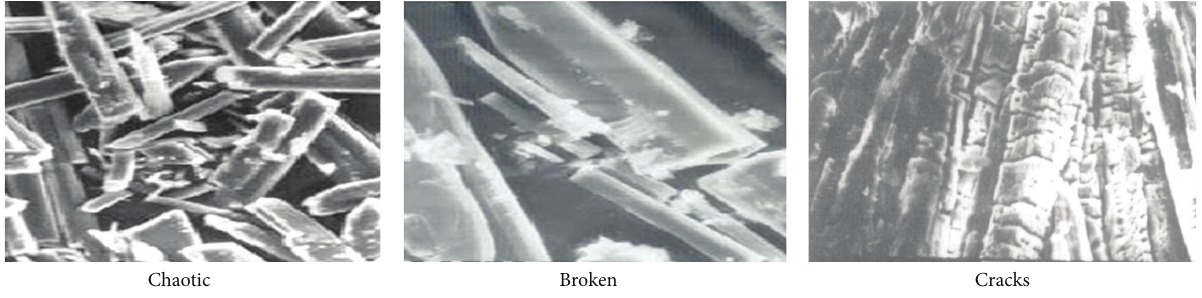
Figure 6: Plank and pillar-like gypsum crystal after SAV-1/SAV-2 treatment.